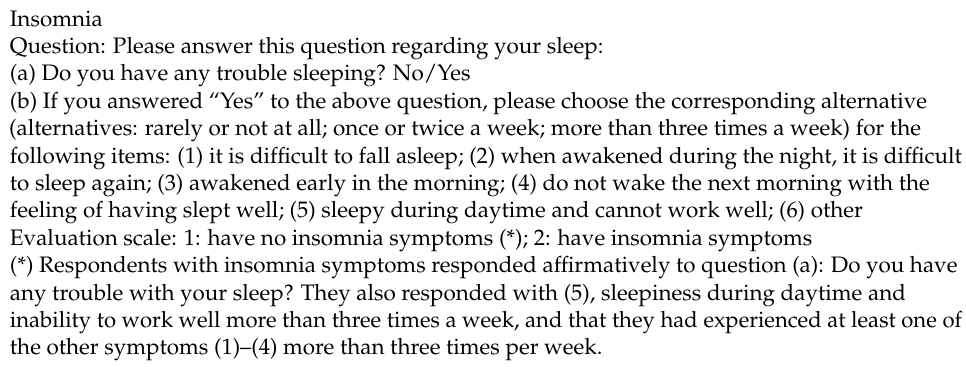
Table 1. Questions and measuring scales used to identify annoyance and insomnia am ong